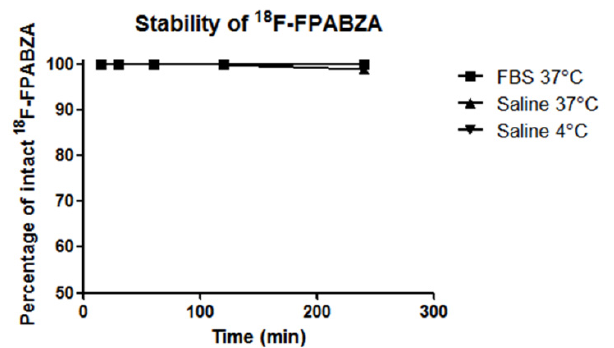
Figure 3. In vitro stability of 18 F-FPABZA in PBS and fetal bovine serum (FBS).